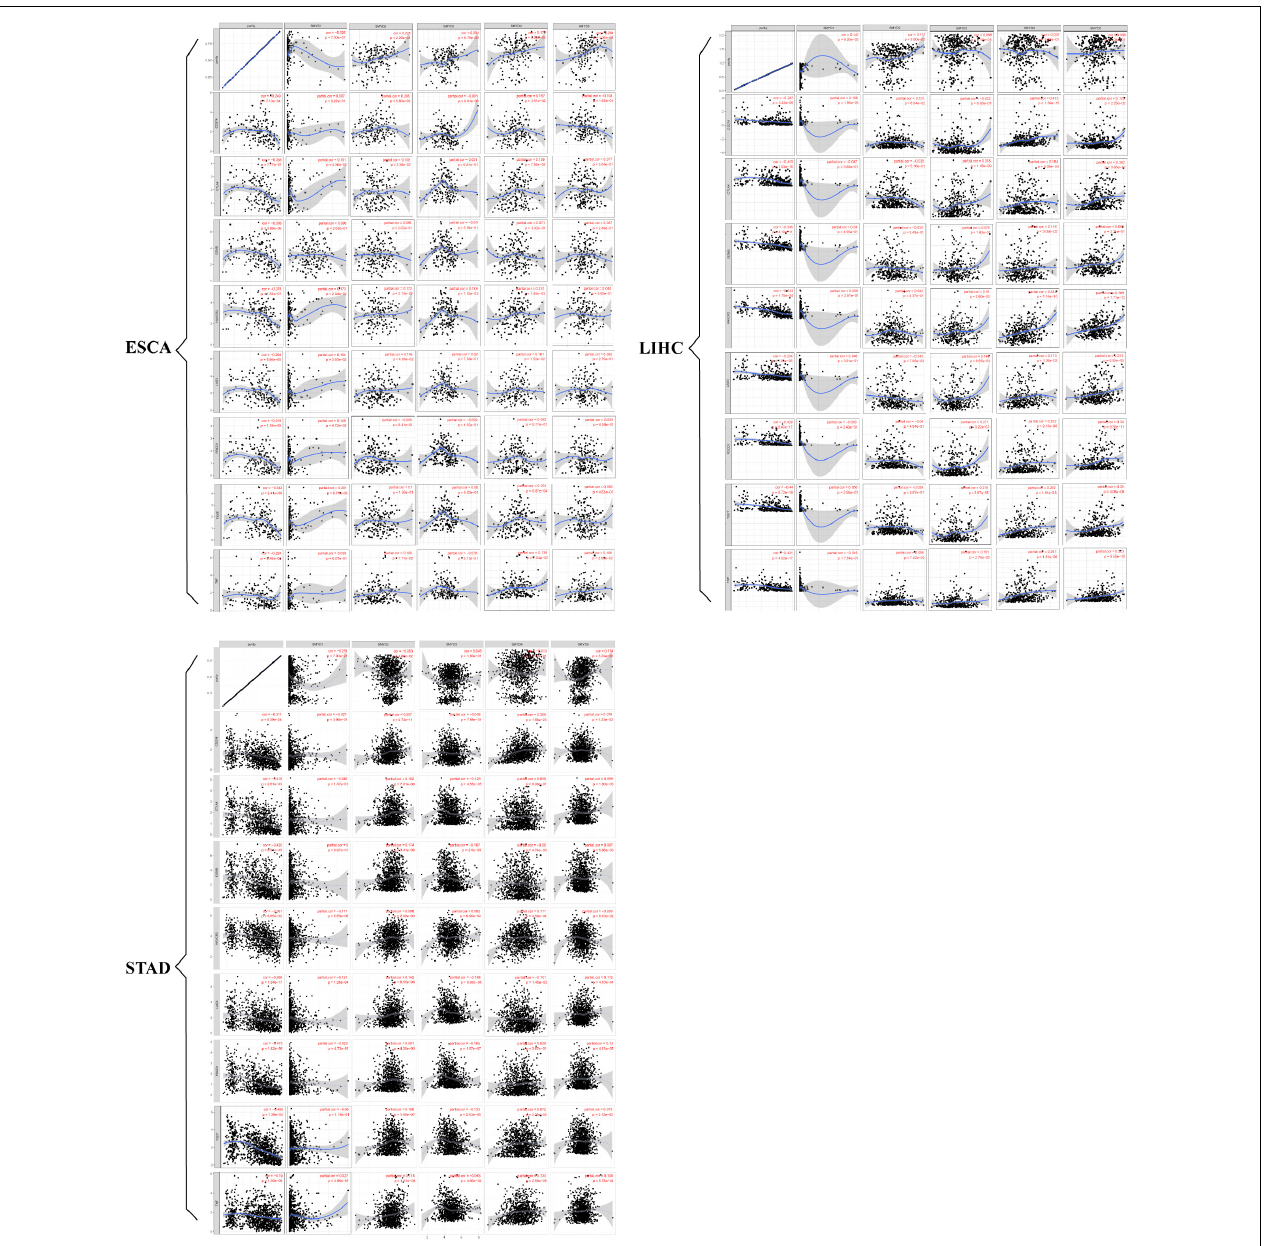
FIGURE 8 | Correlation between SMYD members and immune cell biomarkers, X -axis is SMYD members, Y -axis is immune cell biomarkers, P -value greater than 0 is positive correlation, P -value less than 0 is negative correlation. (Timer) ( P < 0.05 is statistically